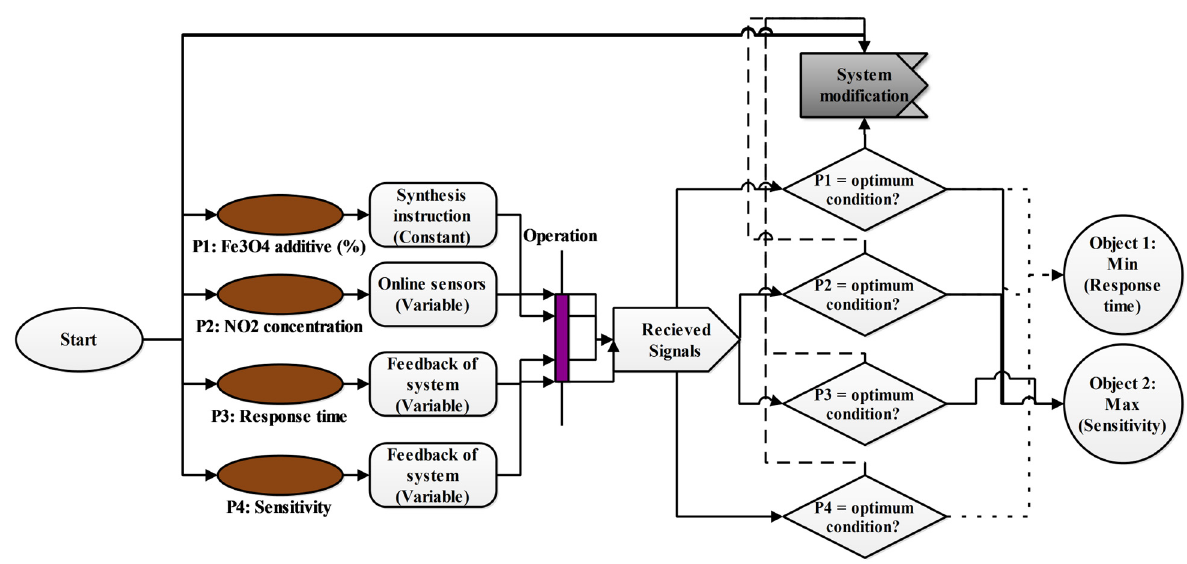
Figure 7. The conceptual model of the gas-sensor control system based on the Jacobson model in the present study.